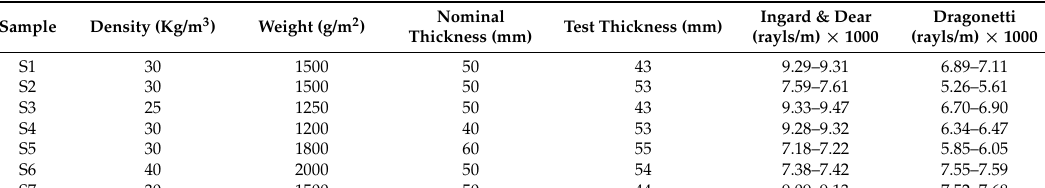
Table 3. Specific airflow resistance measurement results.